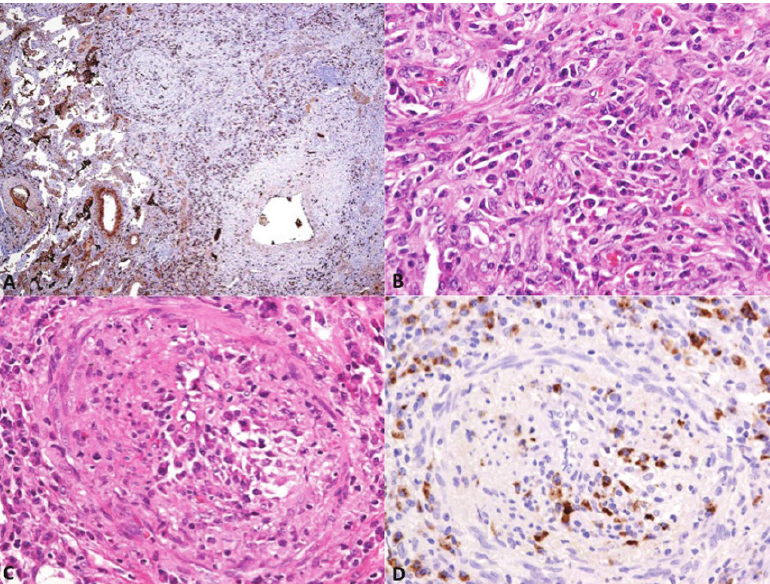
Figure 3 - Lung biopsy of the pulmonary nodule. A: Nodular fibrous lesion with immunopositivity for IgG4 in the infiltrating plasma cells (Verhoeff-Masson trichrome stain, original magnification x 2); B: Plasmacytic infiltration of the fibrous lesion (H&E stain, magnification 6 100); C: Occlusive vascular lesion with plasmacytic infiltration (H&E stain, magnification 6 100); D: Immunopositivity for IgG4 in the infiltrating plasma cells (Verhoeff-Masson trichrome stain, original magnification